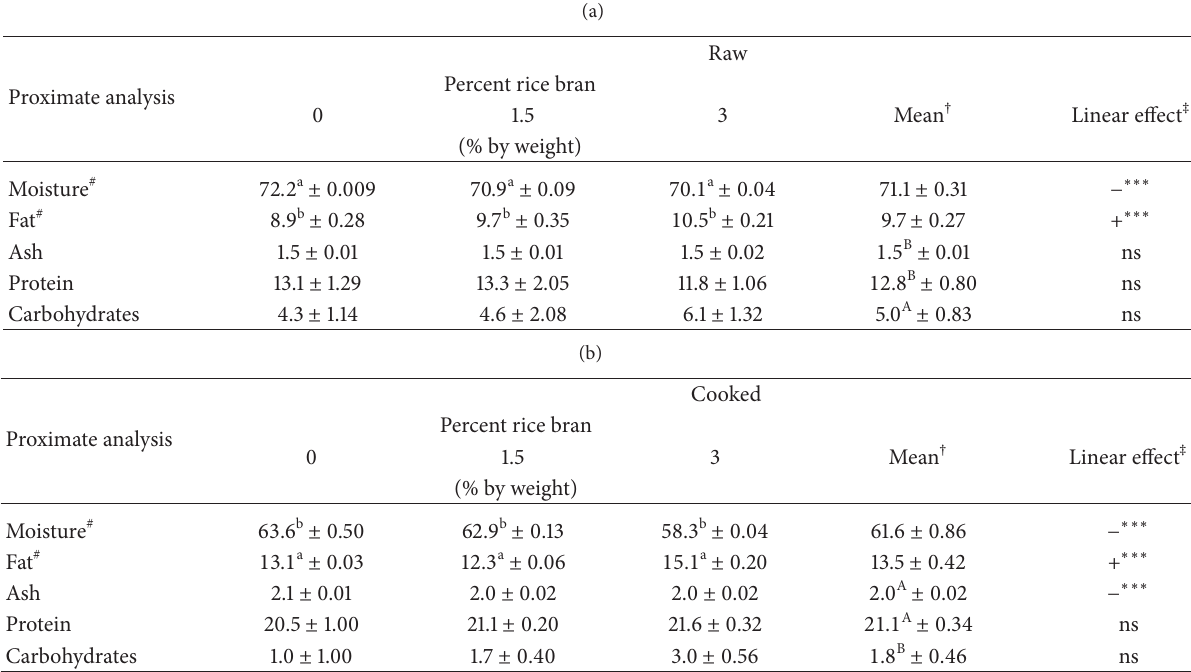
Table 2: Proximate composition of raw and cooked goat meat sausages with added rice bran (Means ± s.e.) §